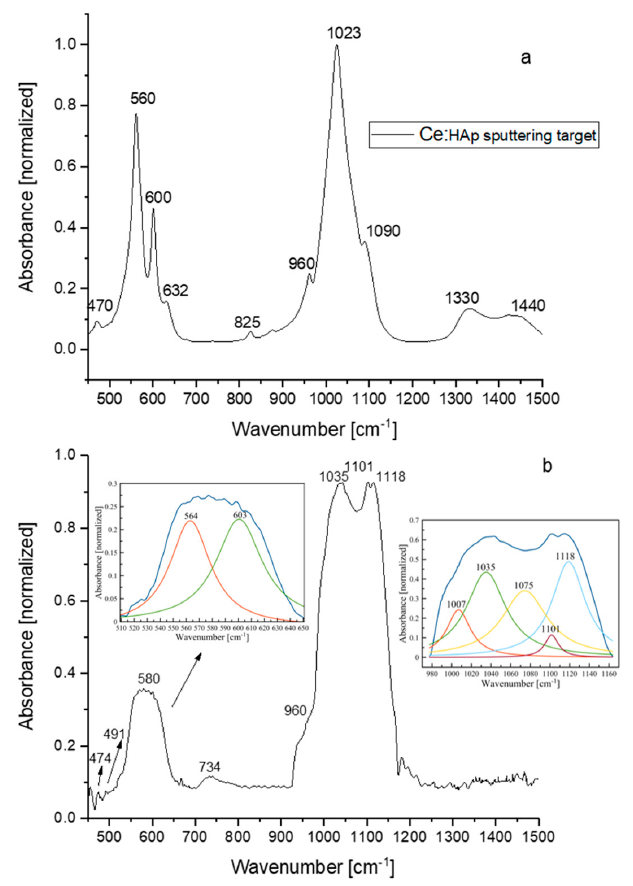
Figure 3. FTIR spectrum of ( a ) the 5Ce-HAp target and ( b ) the 5Ce-HAp coating deposited on the Si